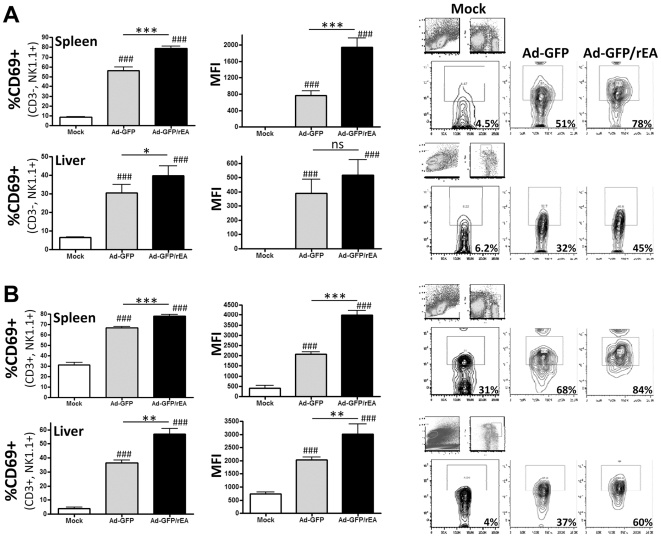
Ad-GFP and Ad-GFP/rEA induced NK and NKT cell activation in liver and spleen in vivo.C57BL/6 mice (N = 3) were either mock injected or injected with 7.5×1010 vps of either Ad-GFP or Ad-GFP/rEA. Lymphocytes from liver and spleen tissue were harvested at 6 hpi, stained for expression of surface markers for (A) NK cells or (B) NKT cells and FACS sorted. Bars represent mean ± SE. #, ##, ### represent significantly different from mock injected mice (p<0.05, p<0.01 respectively). *,**,*** represent statistical differences (p<0.05, p<0.01, p<0.001, respectively). Representative contour plots are illustrated at right. ns, not significant; MFI, mean fluorescence intensity.